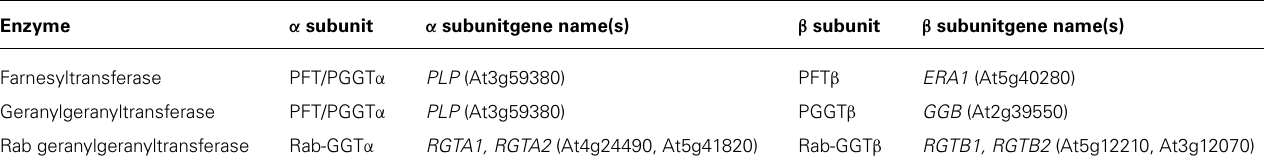
Table 1 | Putative protein prenylation components in Arabidopsis.